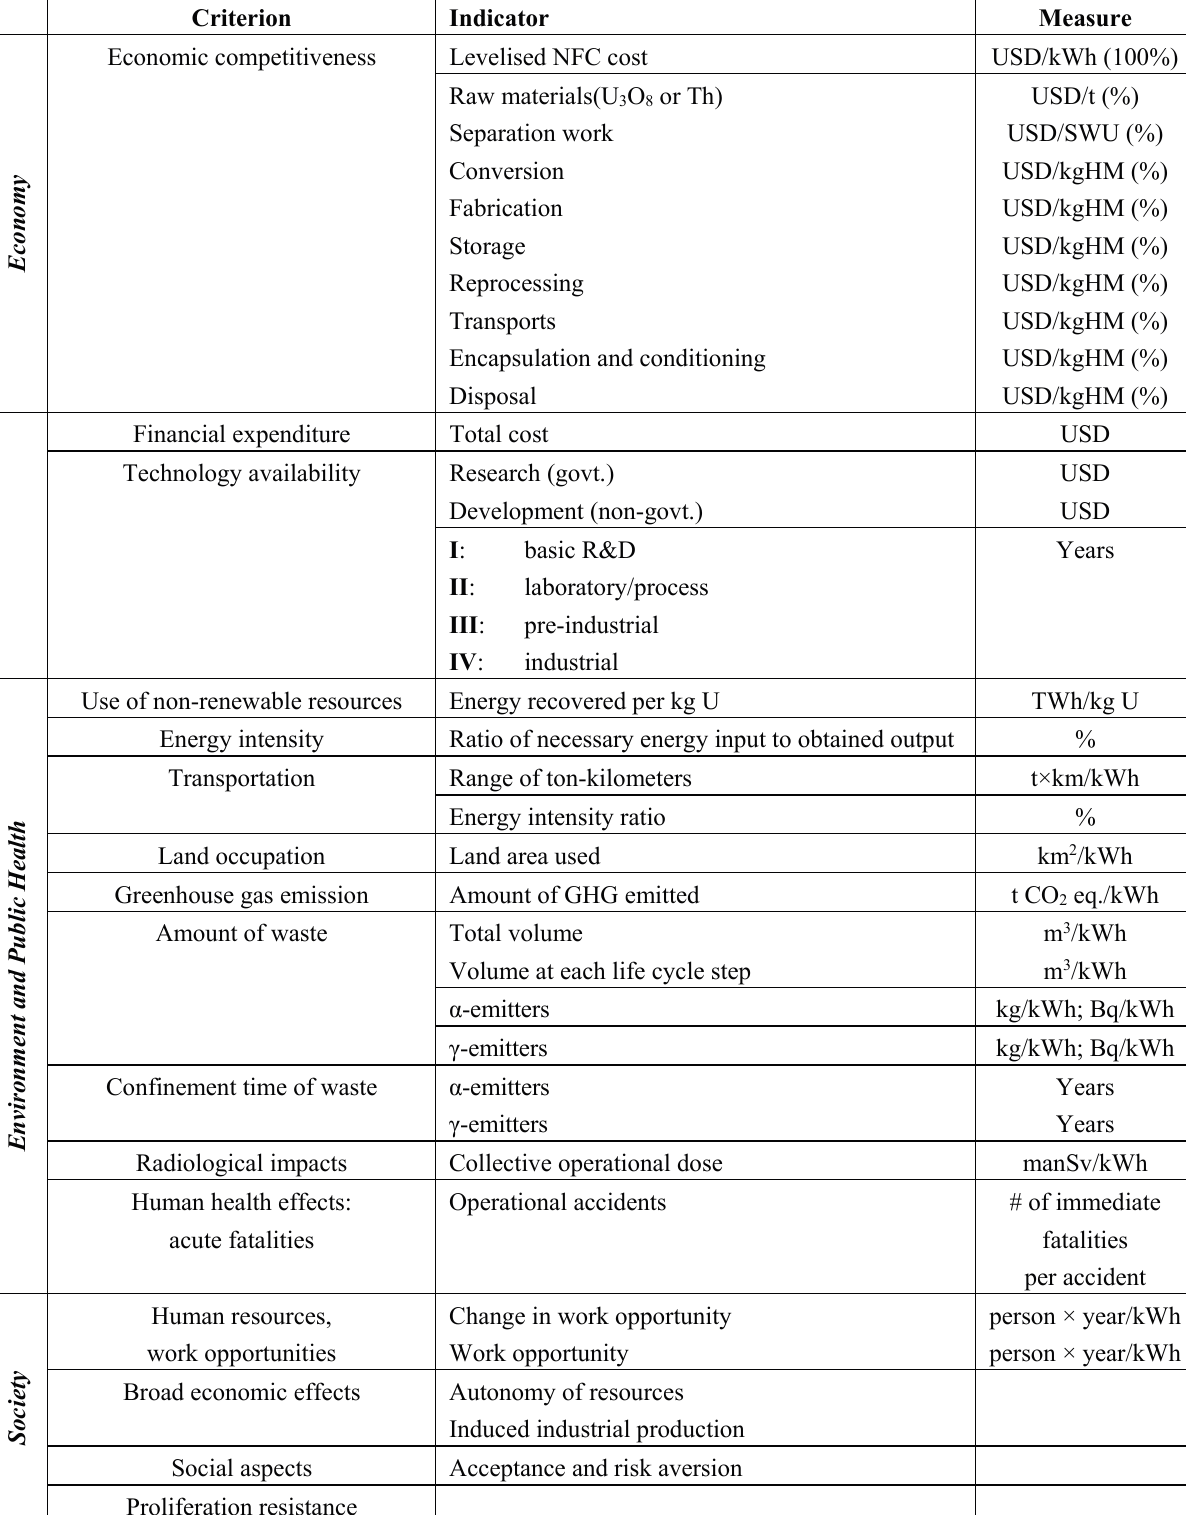
Table 3. Criteria and